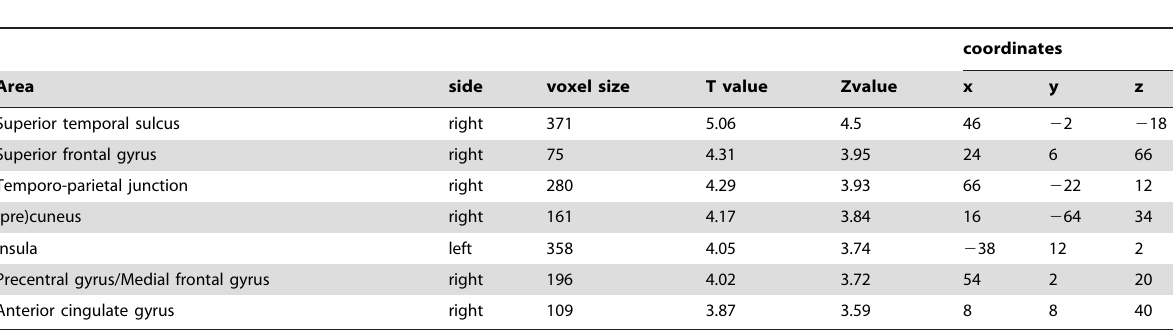
Table 3. MNI coordinates and statistical details for areas that activate in contrast [SC –